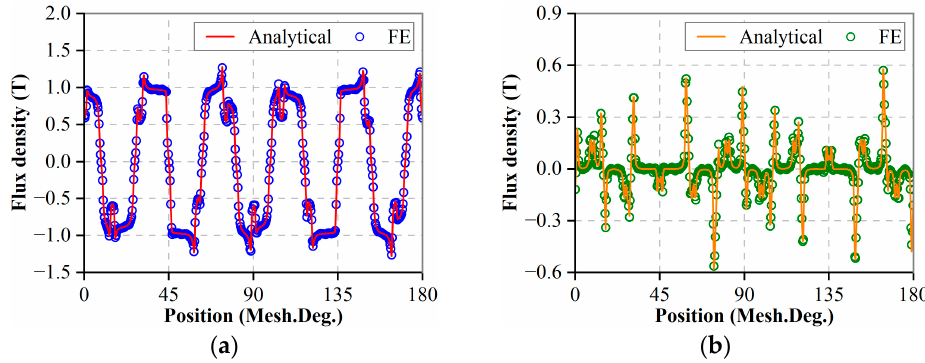
Figure 4. Magnetic flux density in the middle of the air-gap under on-load condition: ( a ) Radial component; ( b ) Tangential component.